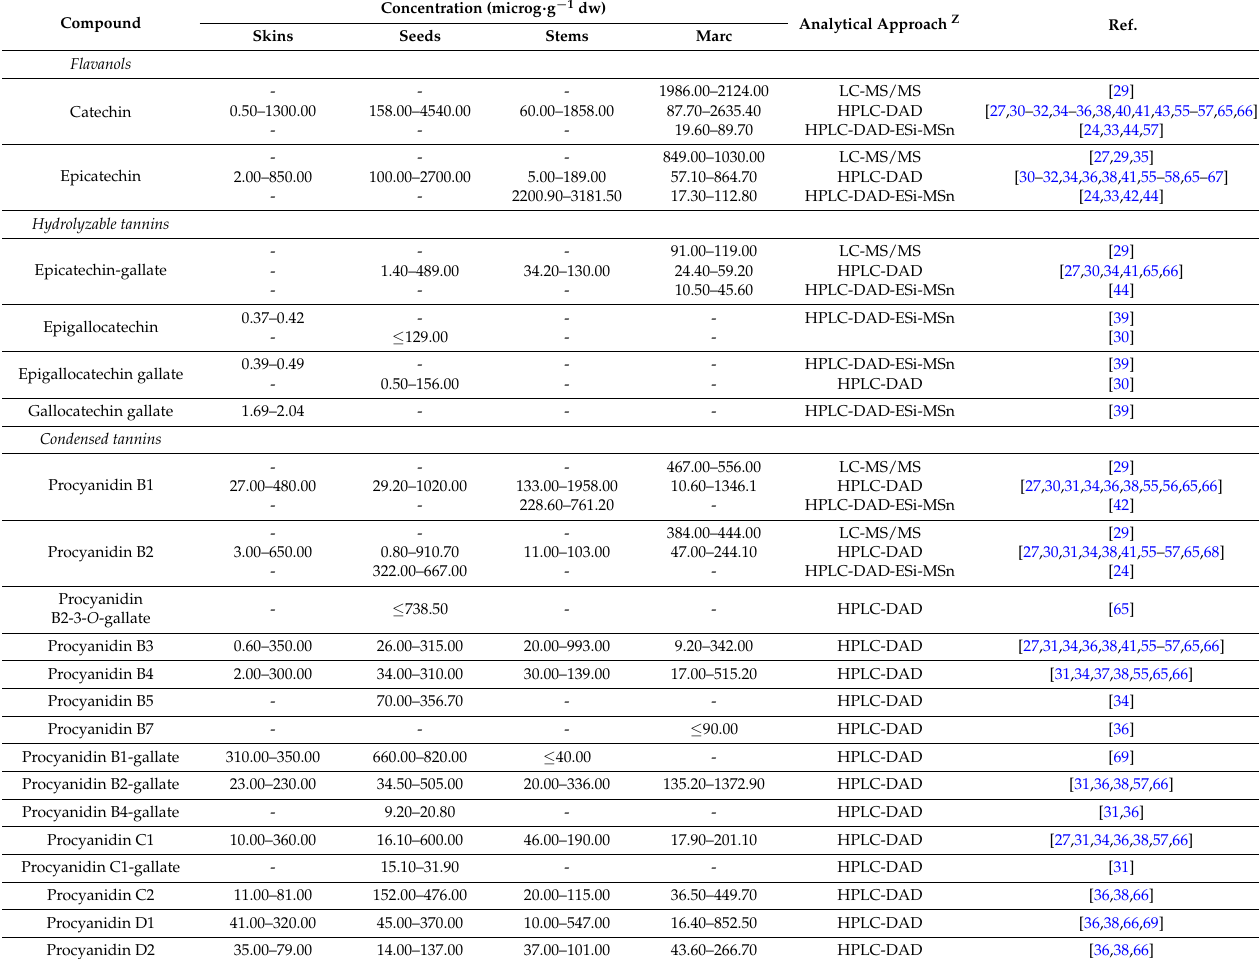
Table 2. Flavanols, hydrolysable tannins, and condensed tannins present in winery